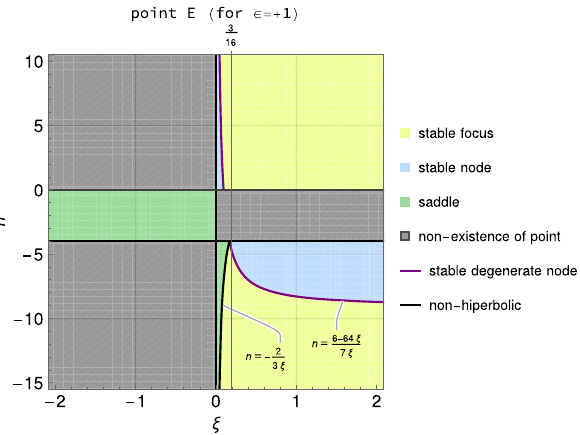
Fig. 4 Bifurcationdiagram ofthe localstabilityofpoint E for ε = +